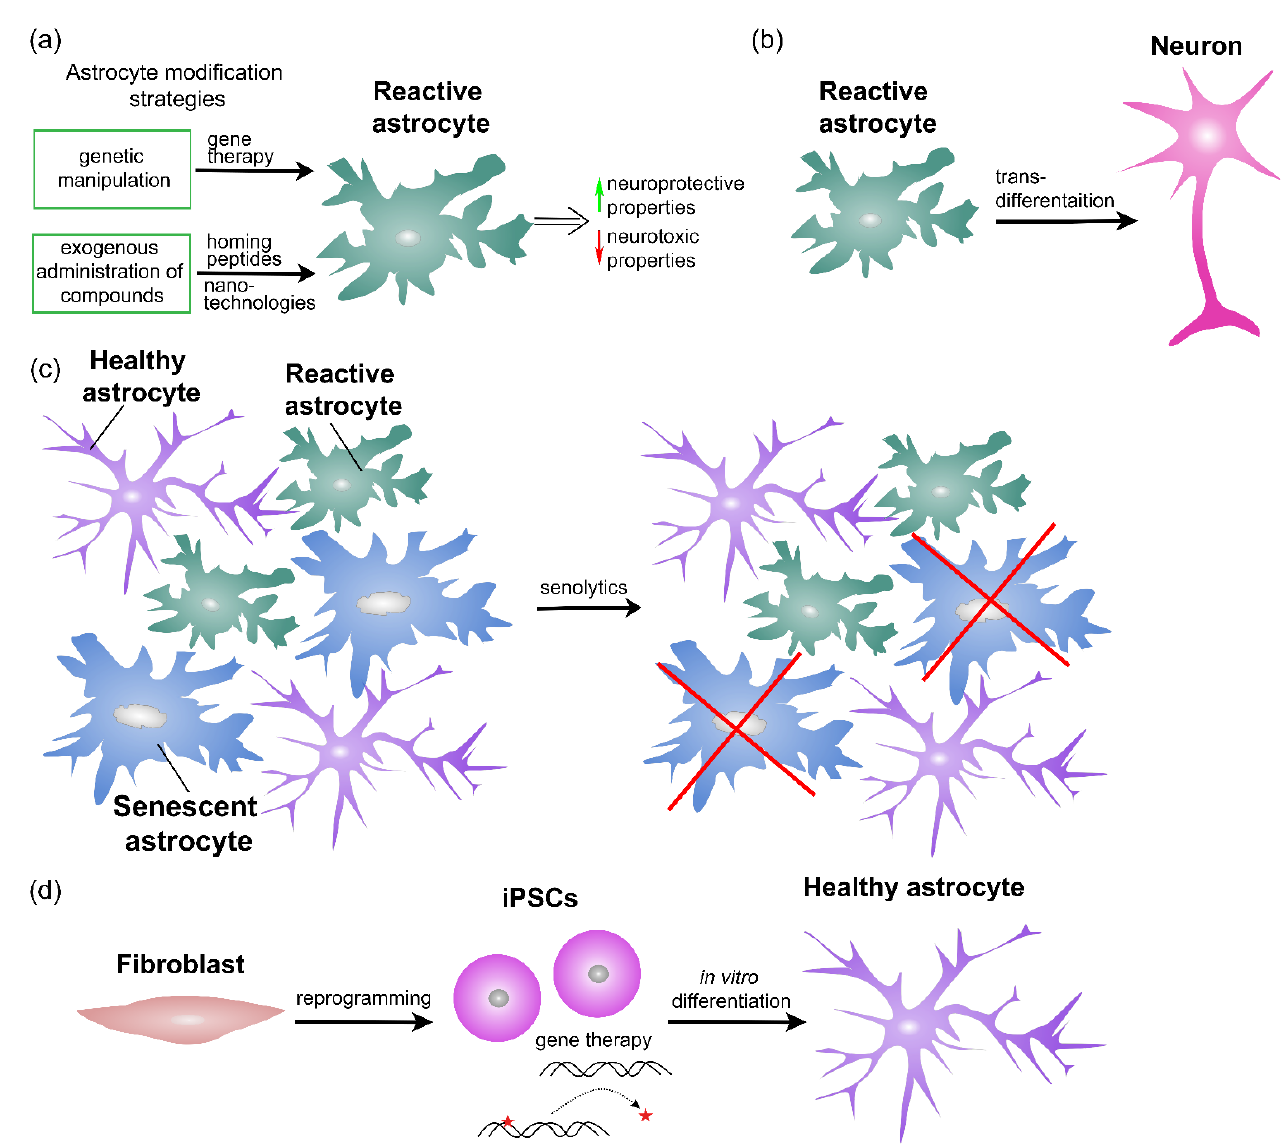
Figure 7. Astrocytes as promising targets for novel therapeutic approaches. ( a ) Therapeutic strategies based on the functional modulation of reactive astrocytics are aimed at enhancing their neuroprotective properties or minimizing their neurotoxic effects. For this purpose, different approaches have been applied, including viral-mediated gene therapy and the exogenous administration of compounds. Different tools including homing peptides and nanoparticles have been used for the selective and specific delivery of therapeutics to astrocytes. ( b ) Transdifferentiation or in situ reprogramming is a process that enables the conversion of endogenous astrocytes to neurons by a forced expression of single or multiple transcriptional factors, which makes astrocytes a valuable source for in situ neuronal tissue repair. ( c ) Possible treatment options in aging and aging-related diseases rely on a new class of drugs known as senolytics that work by selectively inducing apoptosis in senescent cells. ( d ) Cell replacement therapy based on the autologous transplantation of healthy astrocytes to the patients includes the following steps: the patient’s own somatic cells (fibroblasts) are reprogrammed to induce pluripotent stem cells (iPSCs); subsequently, they are genetically manipulated in vitro, then converted to healthy astrocytes and transplanted, without inducing an immune